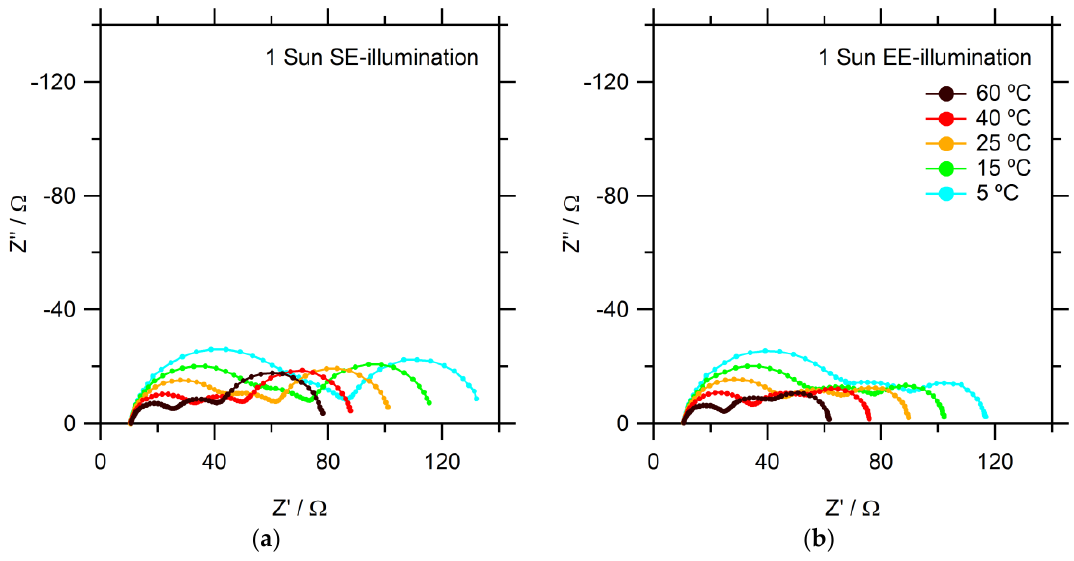
Figure 5. Impedance spectra of a DSSC with Co(bpy) 3 /TPAA/MPN electrolyte at open circuit potential under 1 sun illumination for ( a ) SE- and ( b ) EE- illumination.